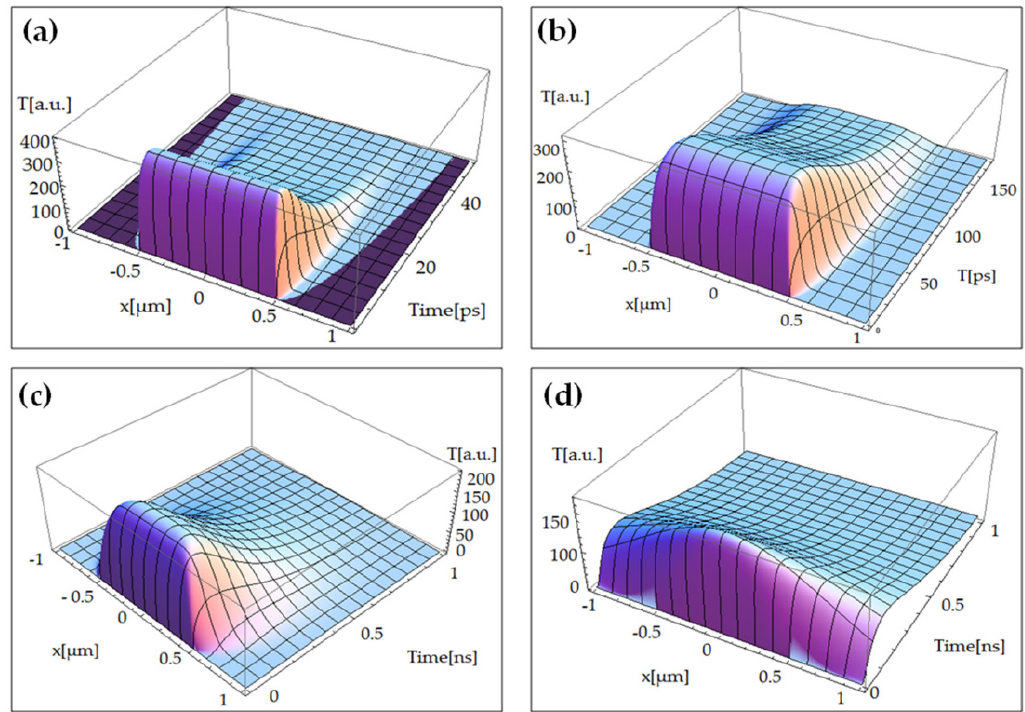
Figure 10. Temperatures field versus current coordinate and time during flash laser irradiation of a single-layer graphene of the ( a ) transverse optical phonons (TO), ( b ) longitudinal optical phonons (LO), ( c ) longitudinal acoustic phonons (LA), and ( d ) transverse acoustic phonons (TA) phonons [72]; published under MDPI’s open access license.